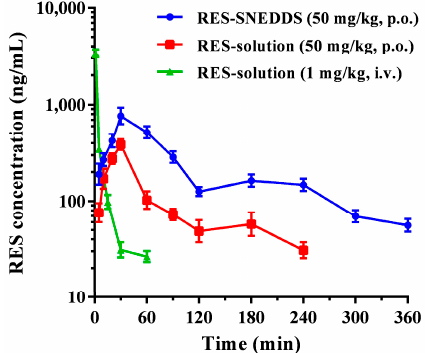
Figure 4. The plasma concentrations-time profiles of resveratrol (RES) after drug administration in rats: ( ● ) indicates the optimal RES self-nanoemulsifying drug delivery system (RES-SNEDDS) (50 mg/kg, p.o.); ( ■ ) indicates RES-solution (50 mg/kg, p.o.); and ( ▲ ) indicates RES-solution (1 mg/kg, i.v.). Data are expressed as mean ± standard error of the mean ( n = 5 for each group). Table 2. Pharmacokinetic parameters of resveratrol (RES) after administration of RES self-nanoemulsifying drug delivery system (RES-SNEDDS) and RES-solution in rats. RES-SNEDDS RES-Solution RES-Solution Parameters (50 mg/kg, p.o.) (50 mg/kg, p.o.) (1 mg/kg, i.v.)